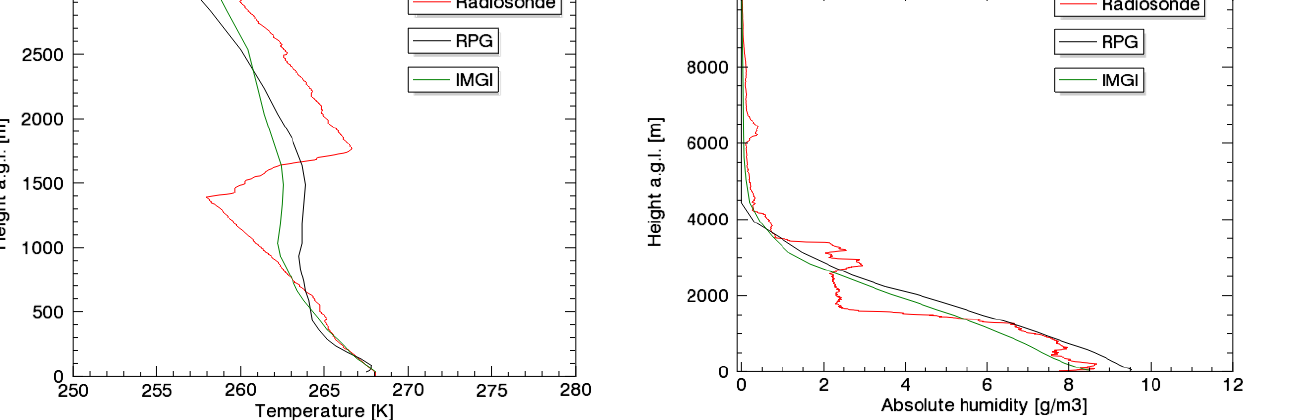
Figure 6. Temperature vertical profile for the lower part of the tro- posphere. The comparison is between (differently colored lines, see inlet) radiosonde, RPG algorithm, IMGI algorithm. They refer to 14 September 2013 at 03:18UTC (launch time of the radiosonde). The height is expressed in meters above ground.